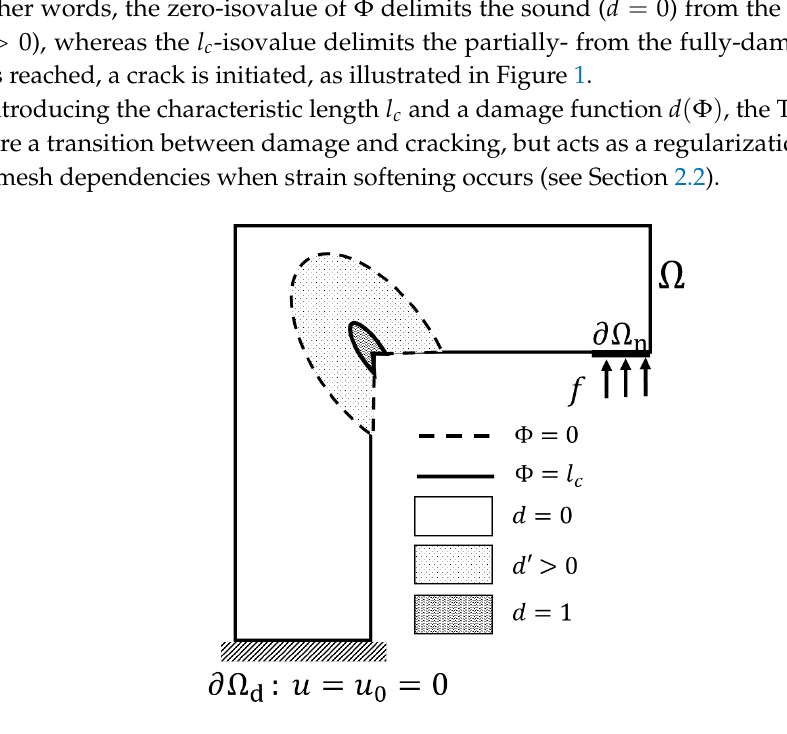
Figure 1. Schematic illustration of the sound, partially-damaged and fully-damaged zones on a computational domain Ω under Neumann and Dirichlet boundary